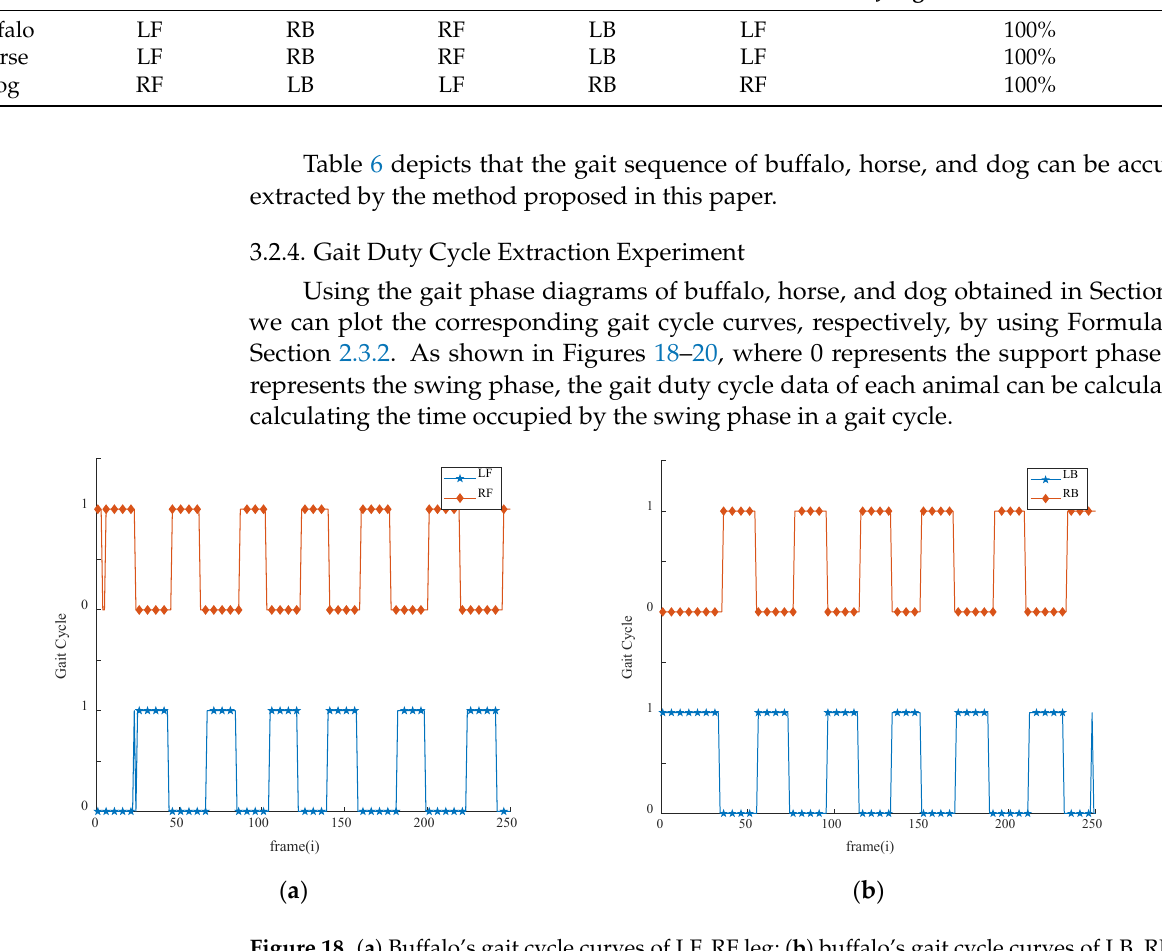
Figure 18. ( a ) Buffalo’s gait cycle curves of LF, RF leg; ( b ) buffalo’s gait cycle curves of LB, RB leg.